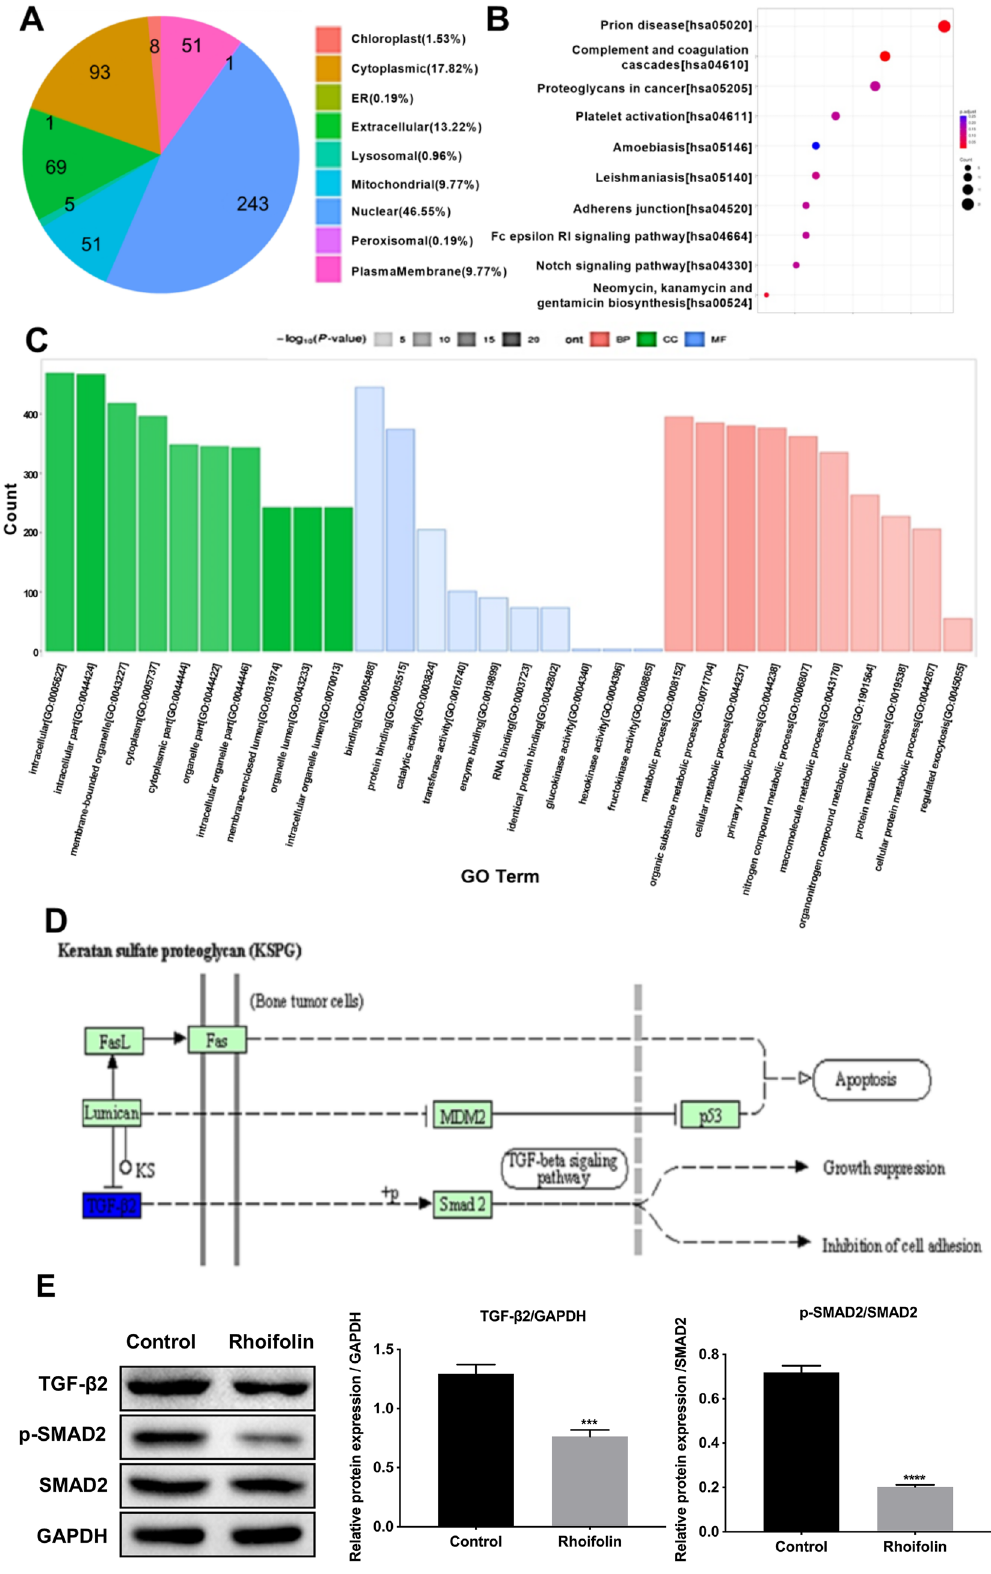
Figure 8. Bioinformatics analysis of DEPs. All 522 DEPs underwent the analysis of subcellular localization ( A ), the enrichment analysis of KEGG signaling pathways ( B ) and Gene Ontology annotation ( C ). ( D ) The DEPs in the “Proteoglycans in cancer” KEGG pathway. ( E ) Western blot analysis of TGF-β2, SMAD2, and p-SMAD2 in PANC-1 cells treated with or without rhoifolin. GAPDH was used as internal